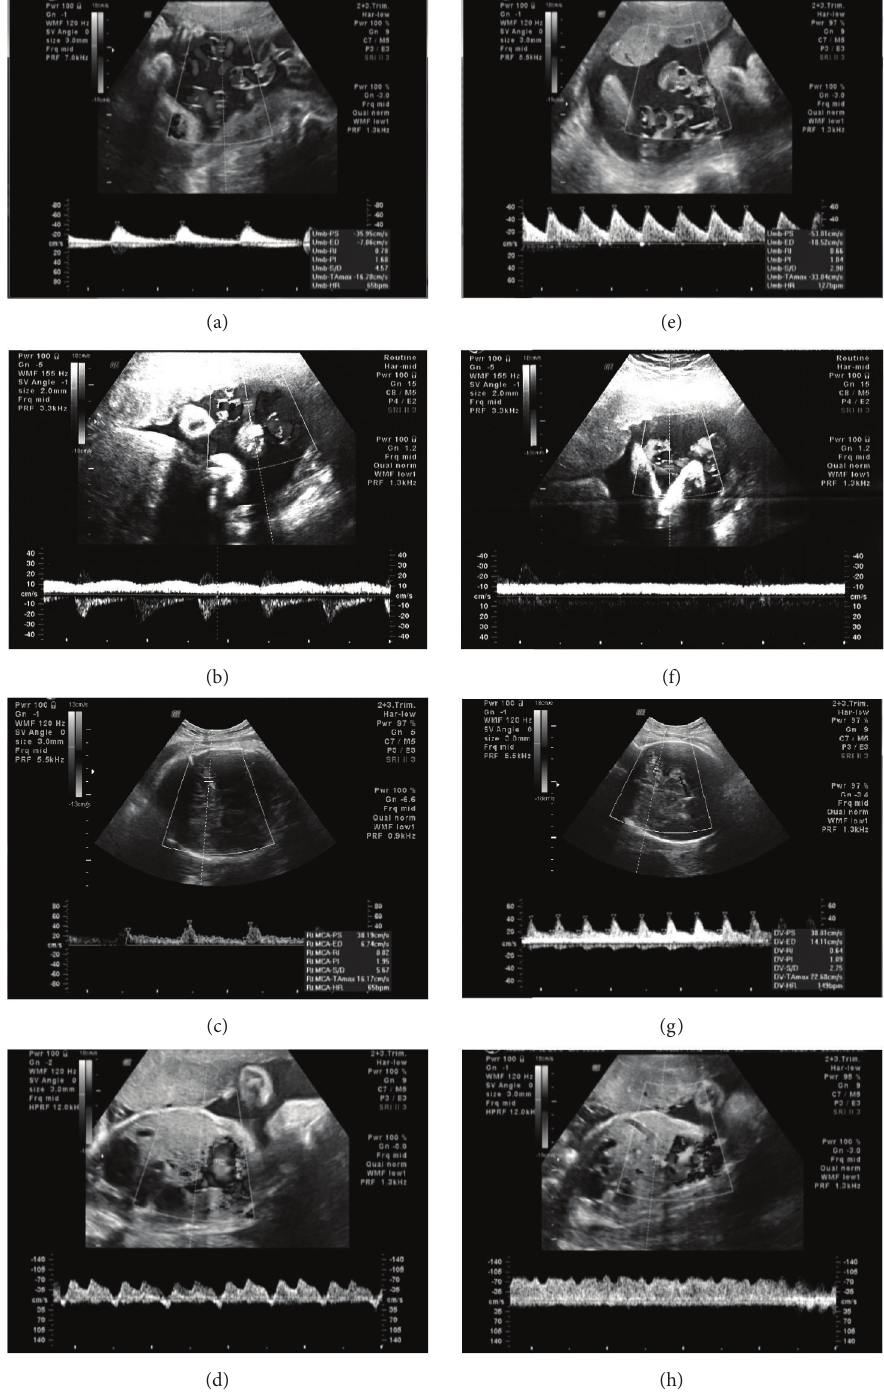
Figure 1: Umbilical artery (a), umbilical vein (b), middle cerebral artery (MCA) (c), and ductus venosus (d) Doppler velocimetry during the deceleration period and Doppler velocimetry of these vessels at normal heart rate, accordingly (e, f, g, h).